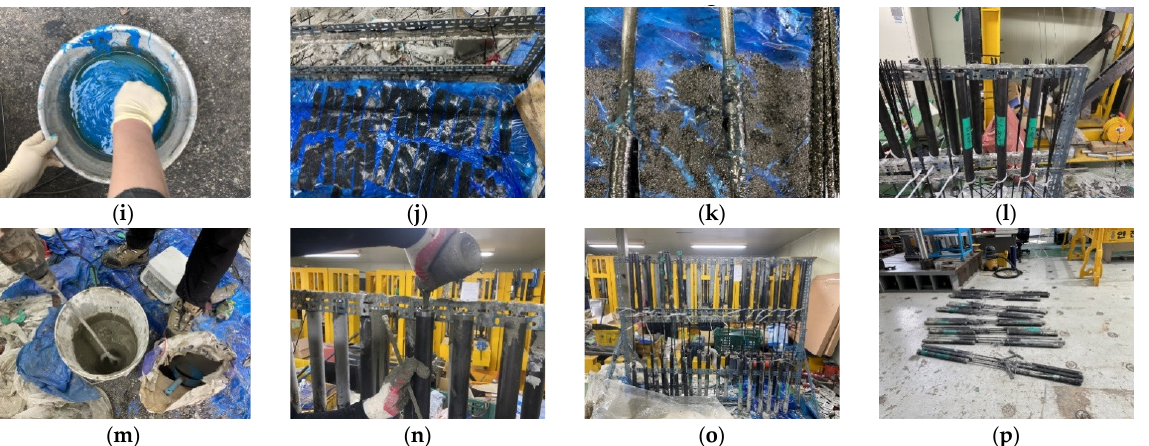
Figure 1. Preparation process for carbon fiber-reinforced polymer (CFRP) specimens used for tensile tests: ( a ) Assembly of holder, ( b ) CFRP cutting, and ( c ) CFRP interface treatment. ( d ) Division of CFRP specimen into nine equal parts. ( e ) Epovia resin mixer, ( f ) first oxide costing, ( g ) second oxide costing, ( h ) completion of oxide coating, ( i ) EPONDEX resin mixing, ( j ) resin coating of the FRP sheet, ( k ) completion of the FRP sheet attachment, ( l ) mounting of the specimen, ( m ) mixing of mortar, ( n ) specimen placement, ( o ) state after placement, and ( p ) completion of the test specimen preparation process.